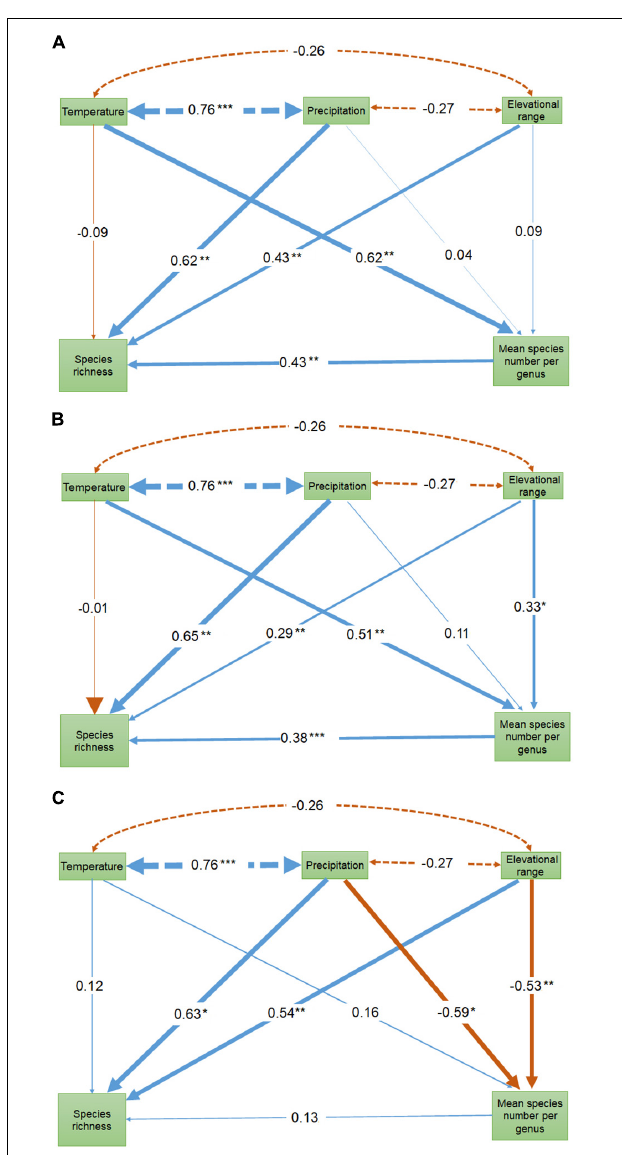
FIGURE 3 | Path diagram showing the interaction among the geographical patterns of temperature, precipitation, elevational range, mean number of species per genus and species richness. The values on the arrows are standardized path coefficients. Blue arrows indicate positive relationships and red values negative relationships. The line thickness of arrows represents the strength of the relationships. The dashed arrows show the Pearson correlation between temperature, precipitation and elevational range. Temperature and precipitation were estimated as the average temperature of the coldest season and the precipitation of the warmest season, respectively. *indicates p < 0.1, ** p < 0.05, *** p < 0.001. (A) All bryophytes (B) Liverworts (C)